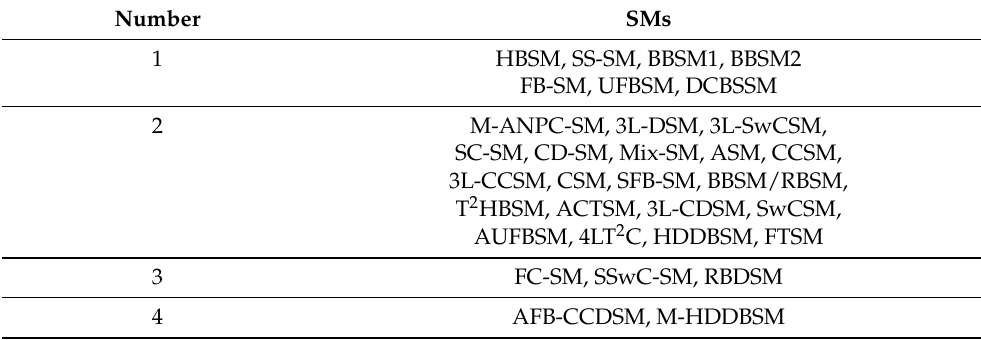
Table 8. Classification of SMs based on Number of Capacitors in SMs.